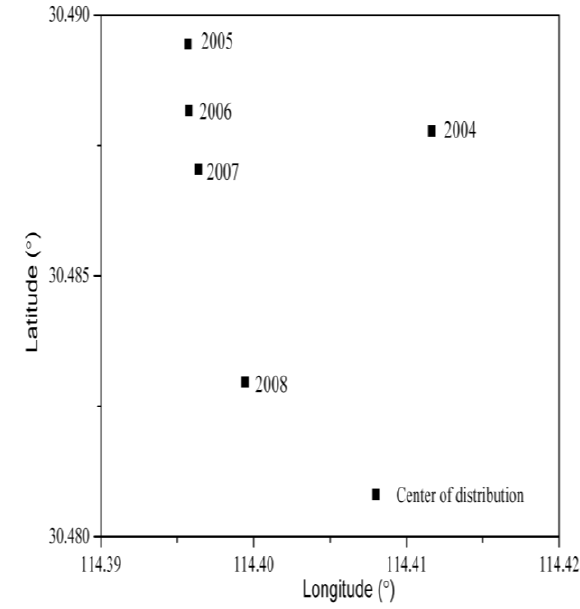
Fig. 6 The center of spatial distribution of enterprises in 2004- 2008